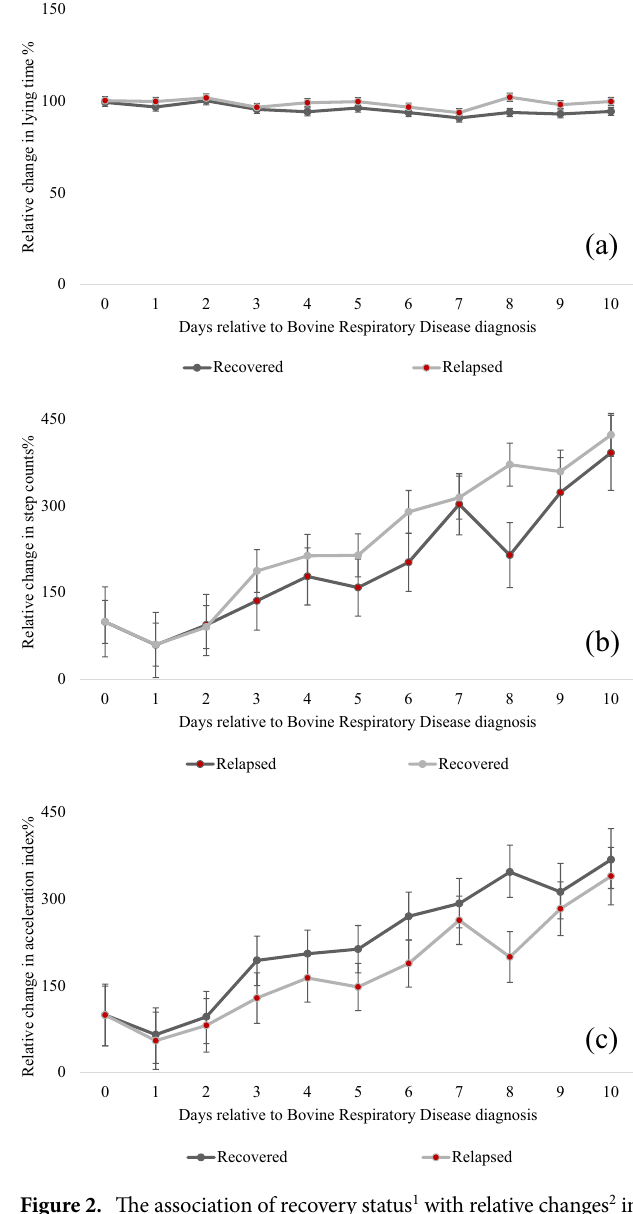
Figure 2. The association of recovery status 1 with relative changes 2 in lying time ( a ), total step count ( b ) and acceleration index ( c ) (LSM ± SEM) for the day of diagnosis (day 0) and the 10 days after antimicrobial intervention for Bovine Respiratory Disease for preweaned, pair-matched calves (n = 19 pairs) offered 10 L of milk replacer/day by an automated feeder. 1 Bovine respiratory disease (BRD) status was defined as a clinical score of ≥ 5 26 lobar lung consolidations ≥ 3 cm 2 and all calves were treated for BRD on day 0. Recovery status was defined as calves that either resolved symptoms of BRD within 10 days post-antimicrobial treatment (recovered) or had clinical BRD status from days 10–14 (relapsed). 2 Relative changes were calculated with day of antimicrobial treatment as a baseline (100%); relative changes were generated by dividing each day after BRD diagnosis (day 1 to day 10) by the baseline (day 0). Significant differences by day are not